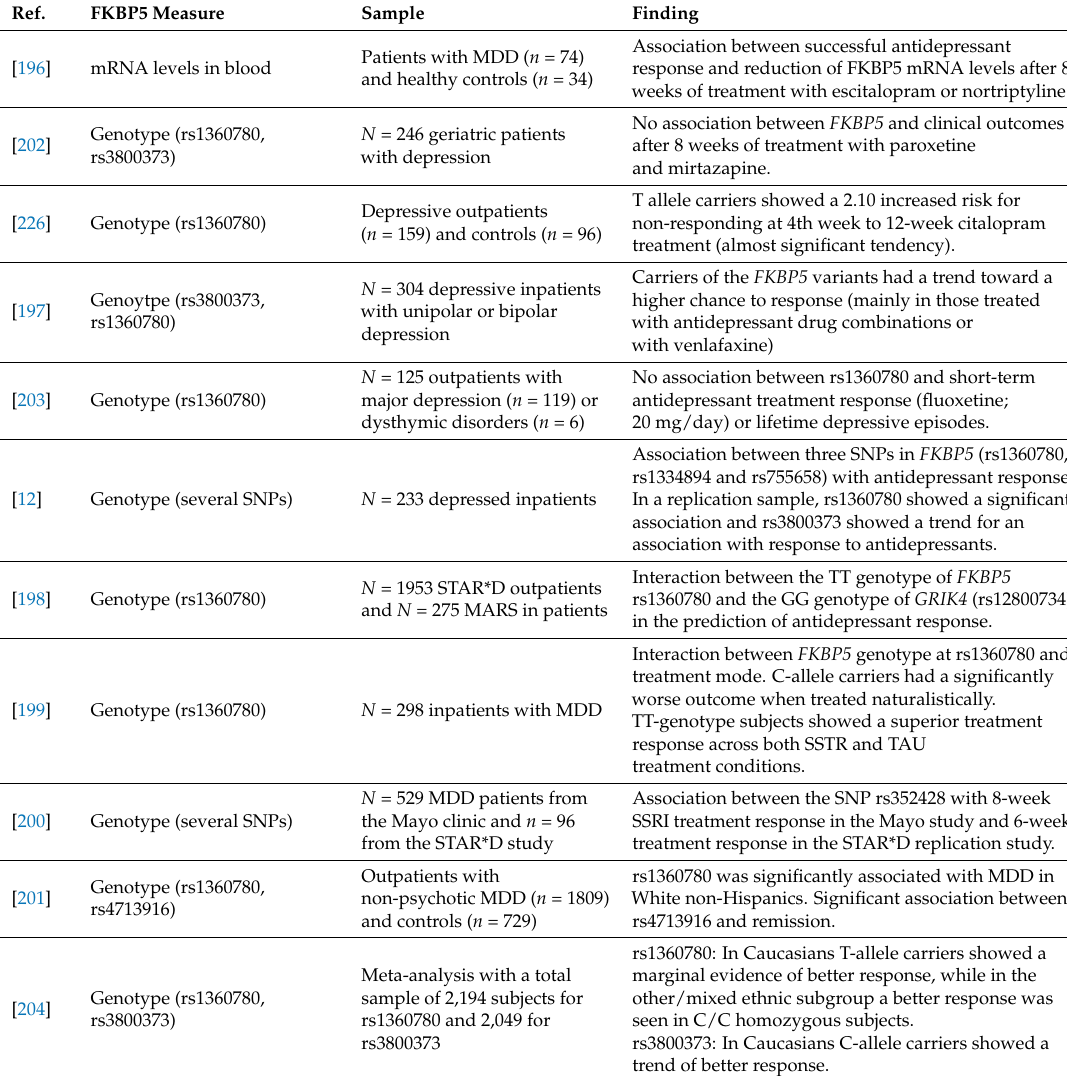
Table 3. Studies investigating the role of FKBP51 in antidepressant